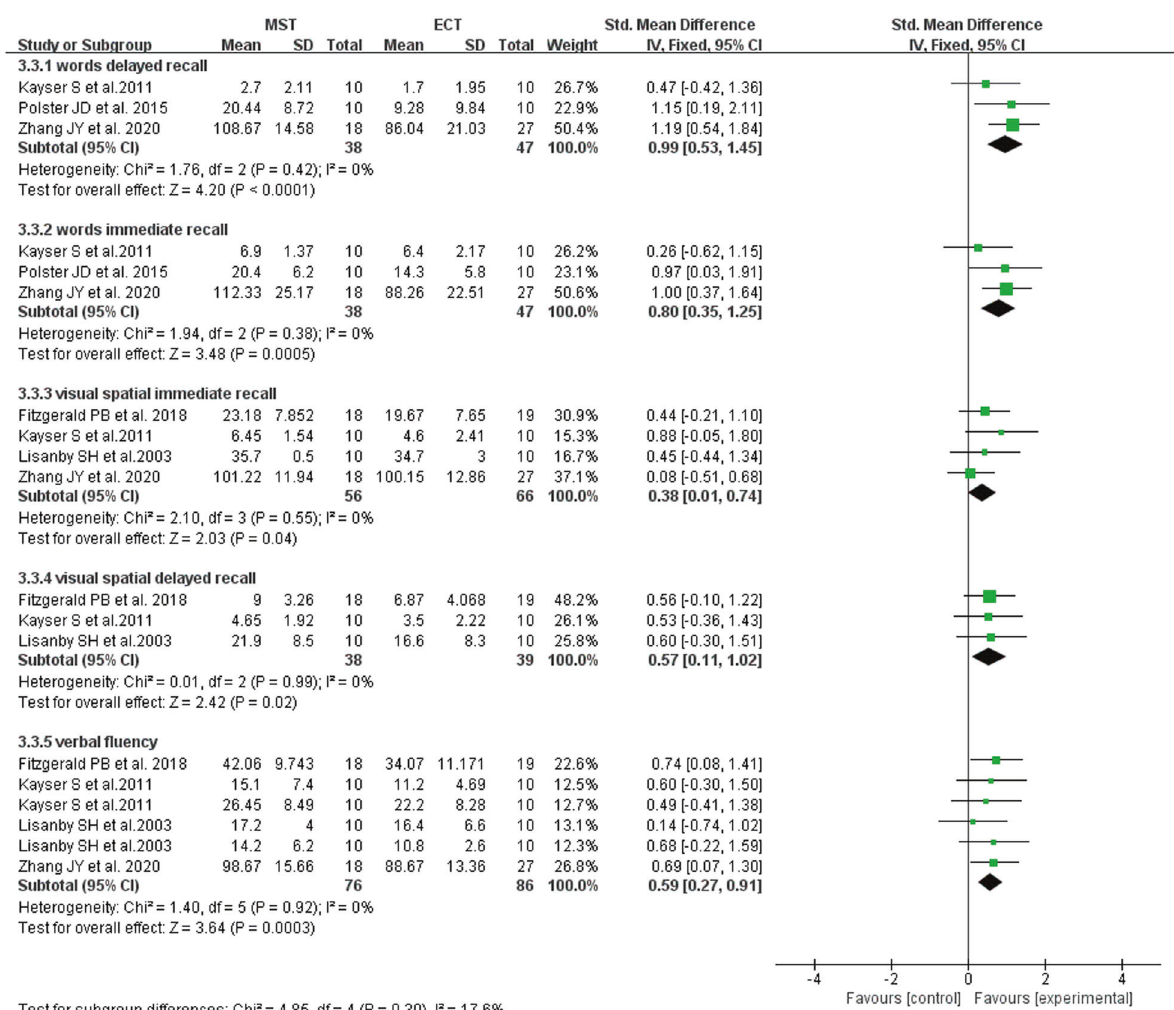
Fig. 5 Forest plot of the impact of MST antidepressant treatment on related to local metabolic changes in depression-related brain regions, and induces neuroplasticity in the frontal cortex through a long-term potentiation-like mechanism, thereby reducing suicidal ideation in patients with depression, which con fi rmed